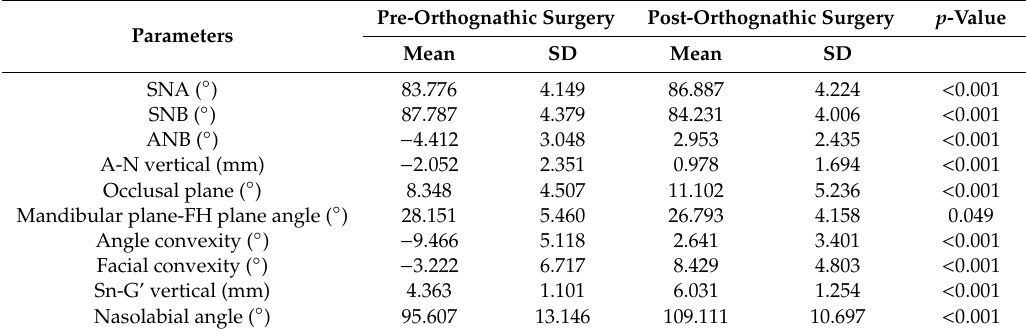
Table 1. Pre- and post-operative characteristics of included